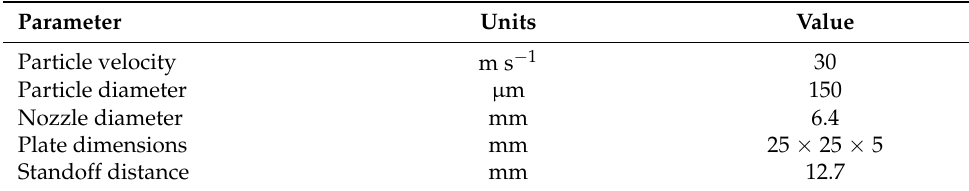
Table 5. Details of the experimental setup for the validation.